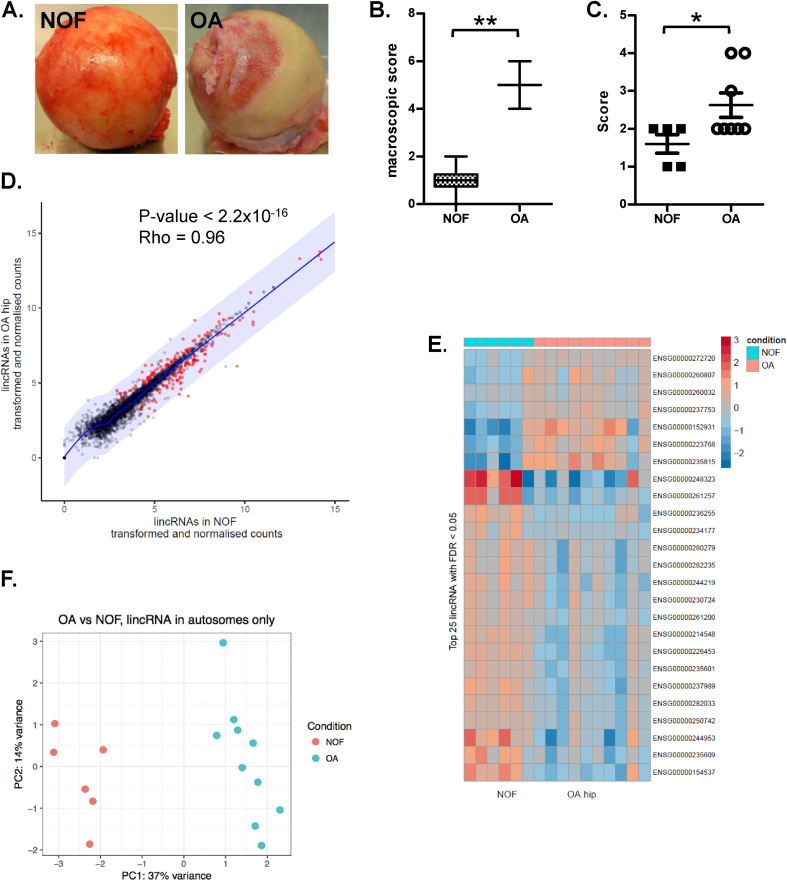
Differential lincRNA expression in NOF compared to OA hip cartilage. A. A NOF and OA femoral head used in this study. The OA femoral heads typically showed exposed bone and fibro-cartilage. B. Blinded cartilage macroscopic scores based on the Noyes classification20. Line mean, error bars are maximum and minimum, **represents P < 0.01. C. Hip osteoarthritis for NOF and OA patients were calculated from X-rays (as described in Methods) to give an overall grade (0–5) based on the Kellgren and Lawrence. Statistical significance was determined using a Mann Whitney U test where * P < 0.05. D. Scatter plot of lincRNA counts in OA vs NOF RNA-seq. Significant lincRNAs (DESeq2, FDR < 0.05) are coloured in red, the shading represents a log2 fold change of 2 from the regression line. A Spearman's rank test was used to assess the correlation between samples. E. Heatmap of top 25 differentially expressed lncRNAs in hip OA (peach) vs NOF (cyan). F. Principal component plot, hip OA vs NOF RNA-seq samples (autosomal lincRNAs only).